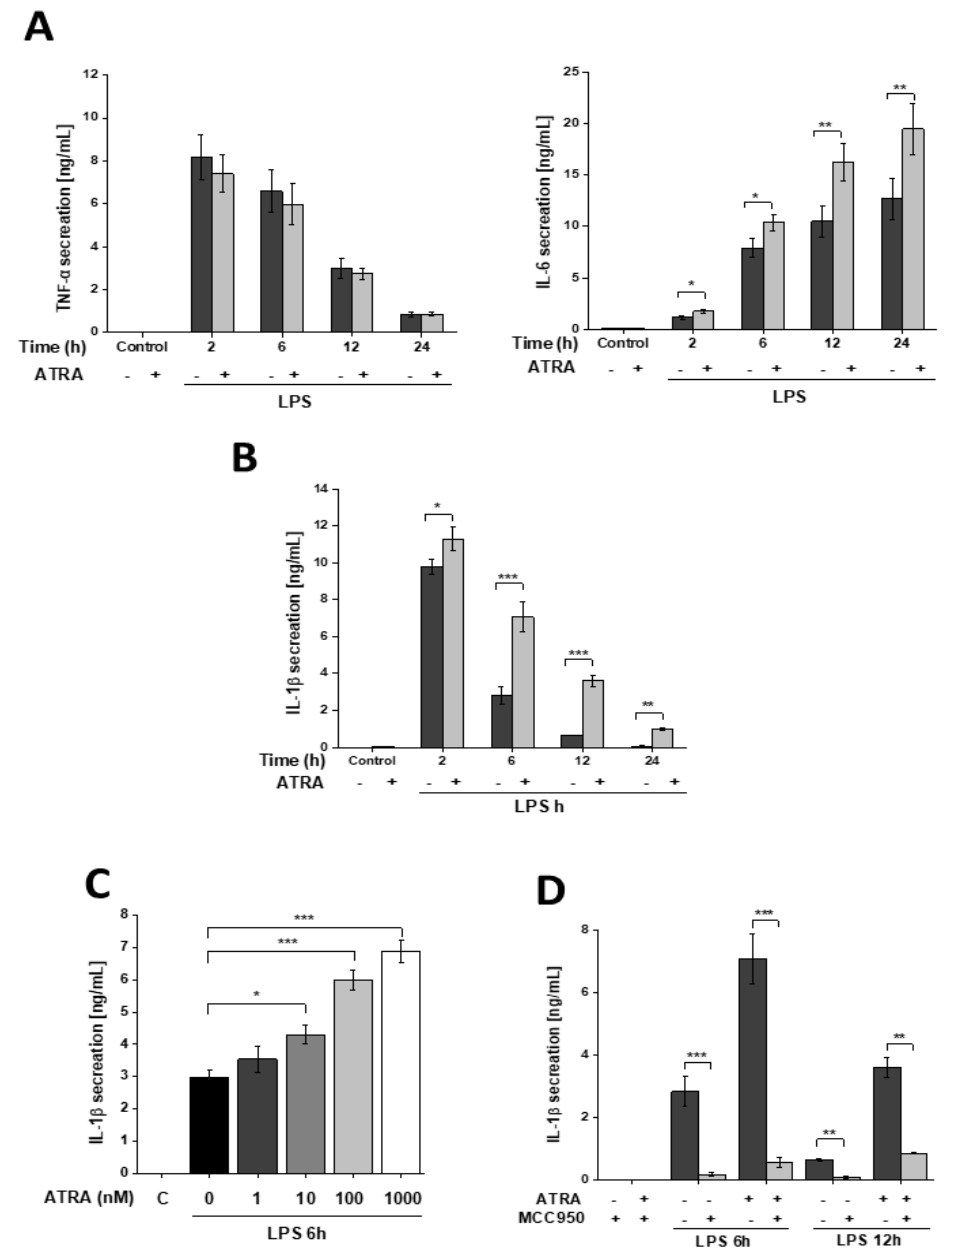
Figure 1. ATRA di ff erentially modulates proinflammatory cytokine secretion of LPS-activated M Φ s. M Φ s were pre-incubated with ATRA (1 µ M) where indicated, and then stimulated with LPS (100 ng / mL) for the indicated time. Cell culture supernatants were collected, and the secretion of ( A ) TNF α and IL-6 were measured by ELISA. ( B ) For IL-1 β induction, cells were subsequently incubated with ATP (5 mM) for 45 min. ( C ) Cells were pre-treated with increasing concentrations of ATRA as indicated, and IL- β secretion was measured 6 h following treatment. ( D ) Cells were pretreated with MCC950 (1 µ M) 1 h before ATP treatment. C, control (6 h mock-treated cells). Data were obtained from at least four healthy donors. All results are shown as means ± SEM. (* p < 0.05, ** p < 0.01, *** p < 0.001). + , − , presence or absence of indicated substance, respectively